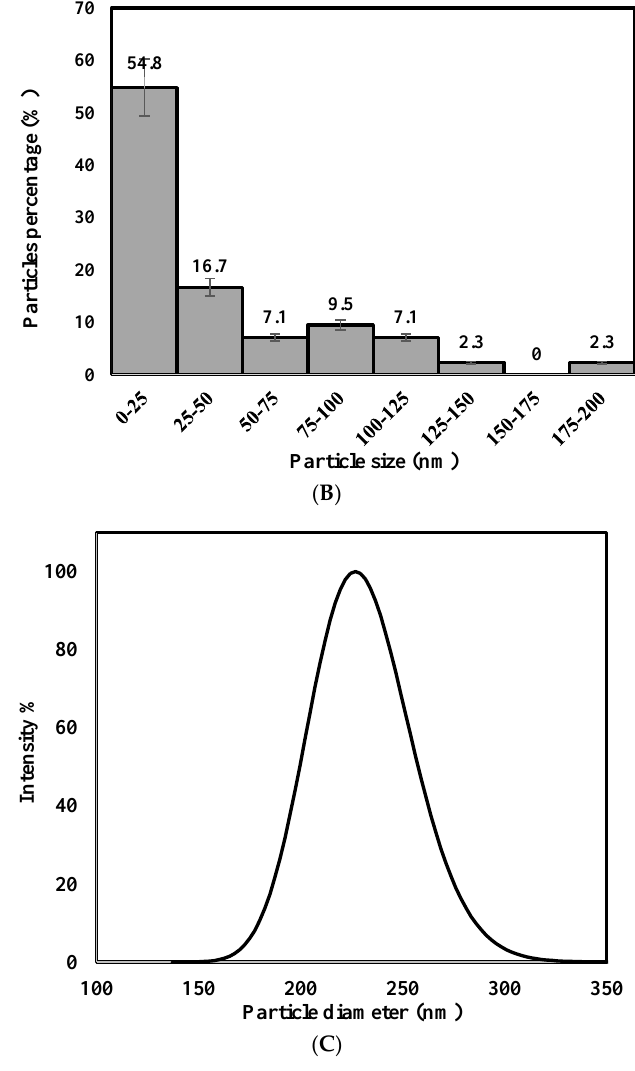
Figure 4. ( A ) Scanning electron microscopy (SEM) image at a magnification of 15 × 10 4 ( a ), and 25 ( b ), transmission electron microscopy (TEM) image at a magnification of 4 × 10 5 ( c ), and 2 × 10 5 ( d ) for FeNP; ( B ) FeNP particles size distribution obtained by Image j analysis of TEM images, and ( C ) FeNP particles size distribution obtained by dynamic light scattering (DLS) analysis.